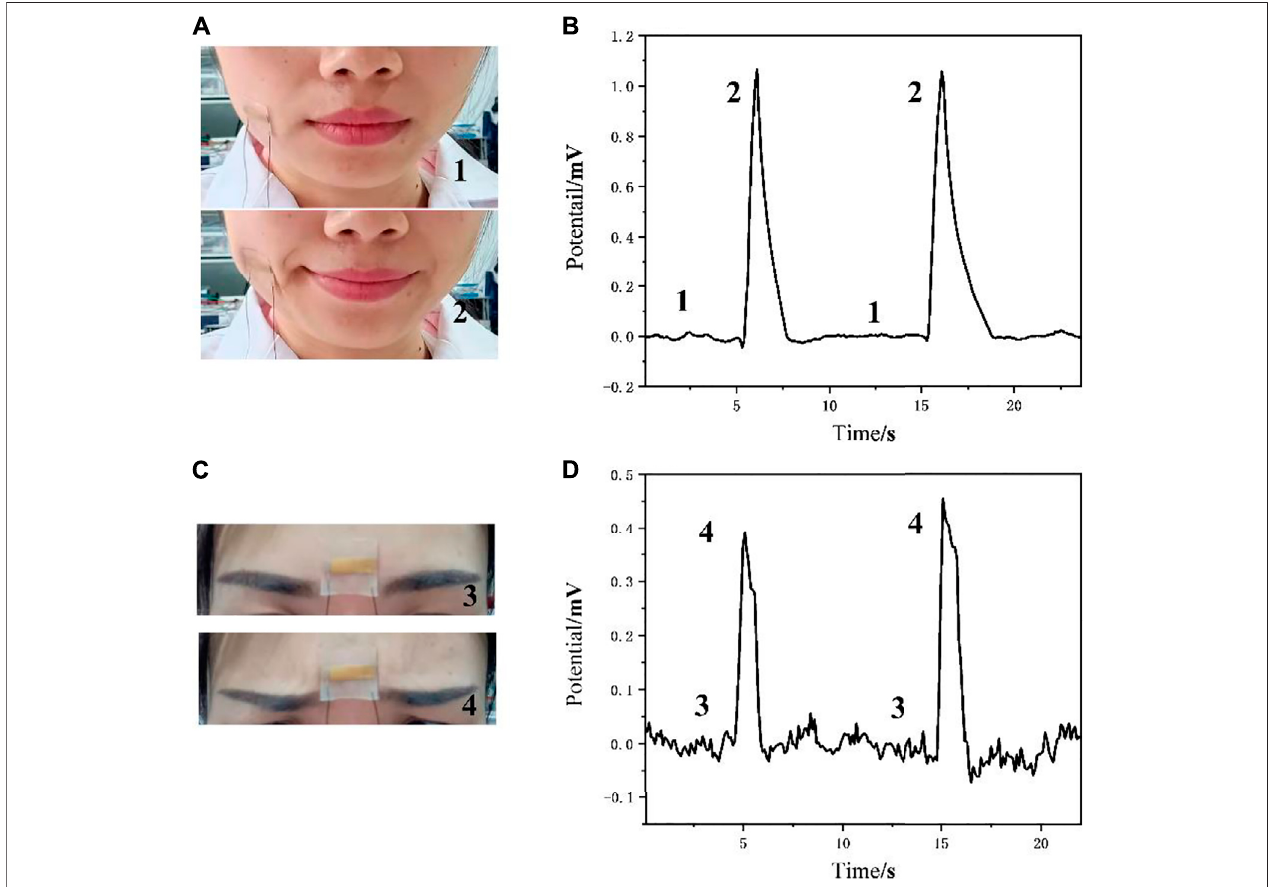
FIGURE 8| Facial expression recognition. (A) Imageof the IPMC sensor taped on the muscle around the mouth, 1 refers to the state without smiling; 2 isthe state when smiling. (B) Voltage response of face muscle shifting from being expressionless to smile. (C) Image of the IPMC sensor taped on the eyebrow center; 3 means no frowning; 4 means frowning. (D) Voltage response during